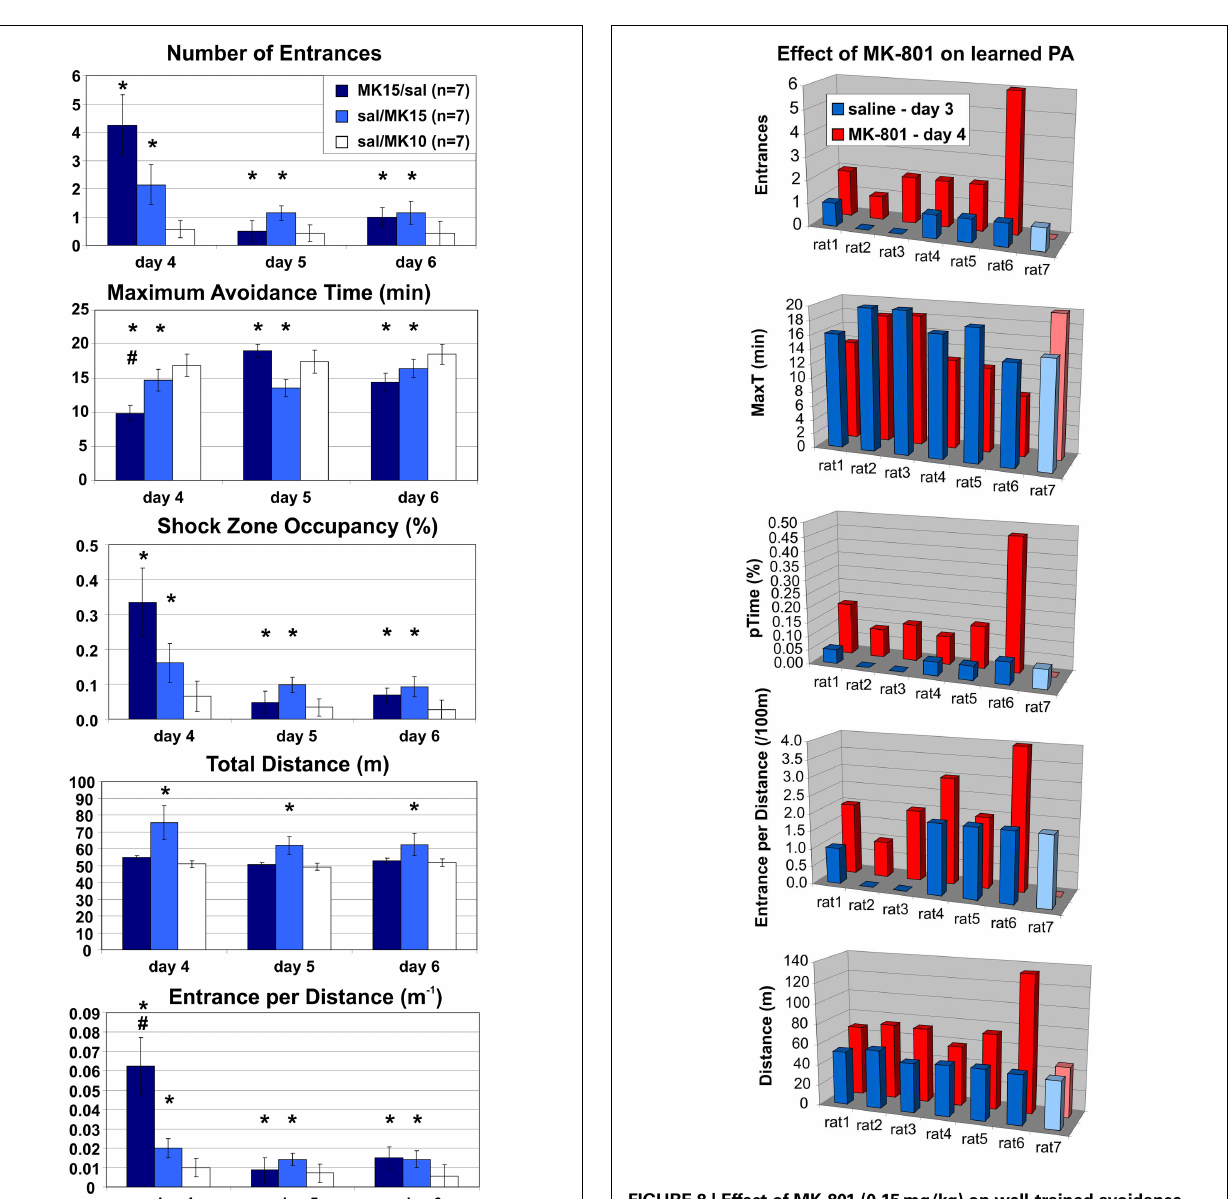
FIGURE 8 | Effect of MK-801 (0.15mg/kg) on well-trained avoidance . MK-801 impaired avoidance and increased locomotion in all animals (sal/MK15) except rat 7. Rat 6 deteriorated approximately three times as much as other rats (except MaxT). 0.10 mg/kg MK-801 treatments in behaving animals (A/A and A/B) as opposed to 0.15 mg/kg MK-801 treatment and CC,